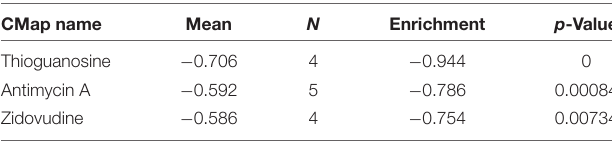
TABLE 3 | Three small molecule compounds identified as potential drugs for glioma treatment in CMap